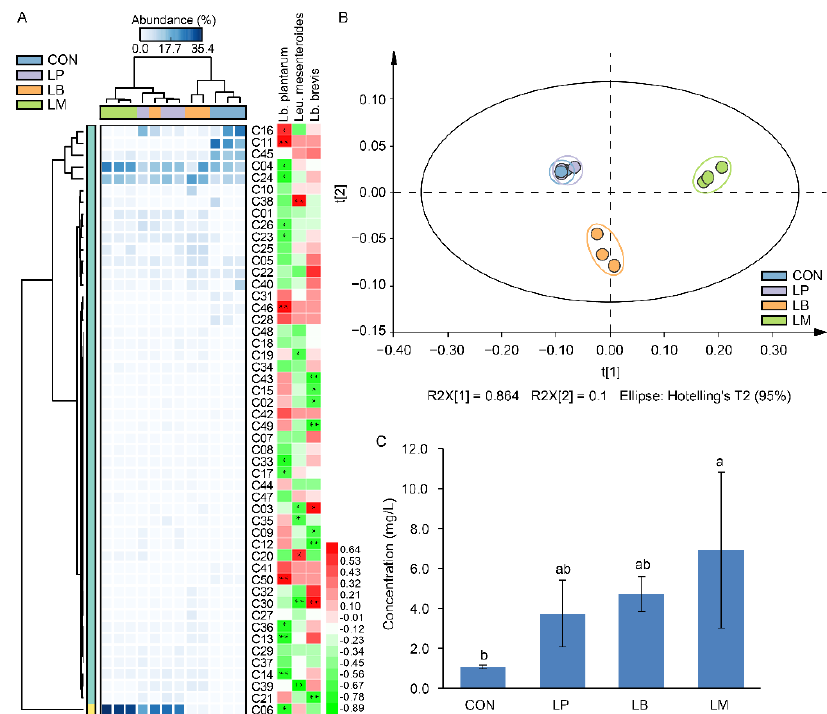
Figure 3. The heatmap and correlation analysis with LABs ( A ), scatter plot ( B ), and total concentration ( C ) of volatile flavor compounds in Suancai fermented with different autochthonous LABs. Different letters represent significant differences ( p < 0.05). * p < 0.05, ** p < 0.01.